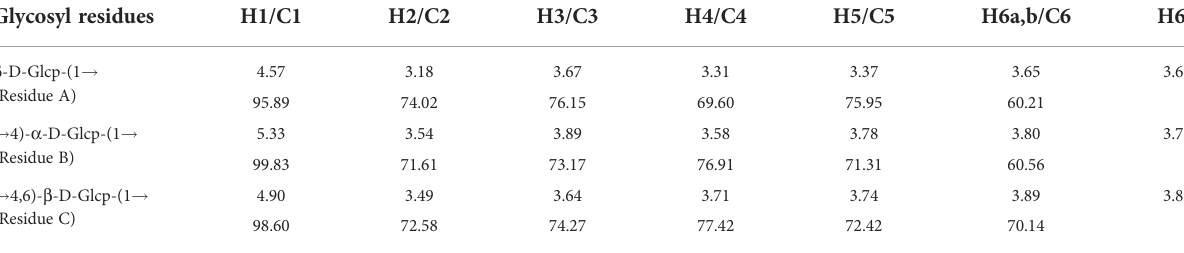
TABLE 2 Summary of 1 H and 13 C NMR chemical shifts for